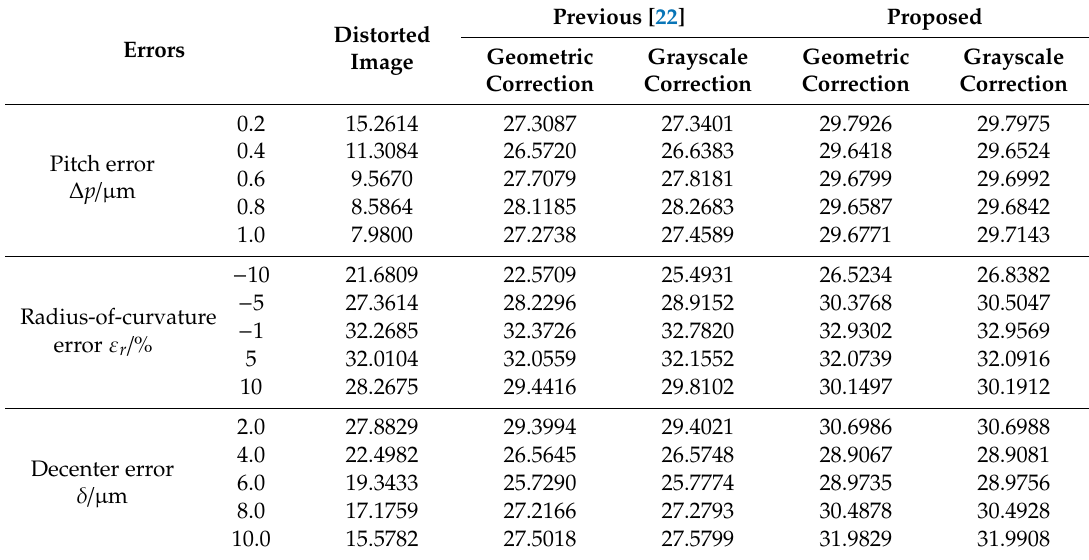
Table 2. Quantitative comparison of di ff erent correction methods for MLA form